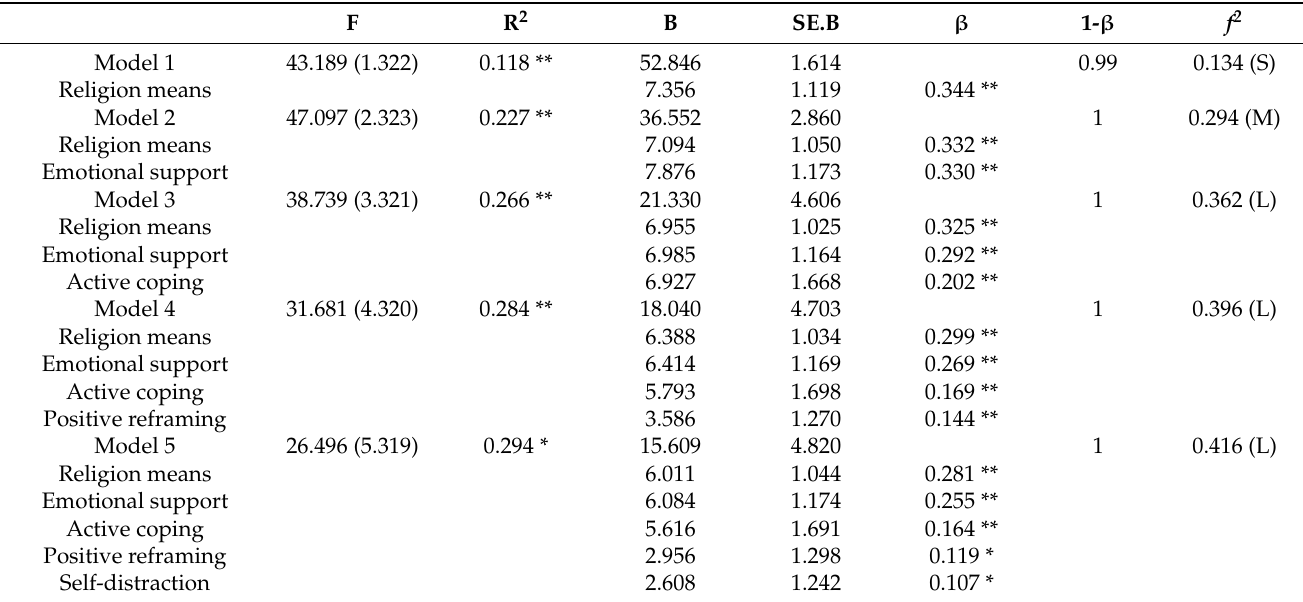
Table note: L = large effect size, M = medium effect size, S = small effect size. Significance value * p < 0.05, ** p < 0.001. At T3, the coping strategies that predicted the PGI-21 total score were positive refram- ing ( β = 0.269, p < 0.001), instrumental support ( β = 0.215, p < 0.001) and religion ( β =